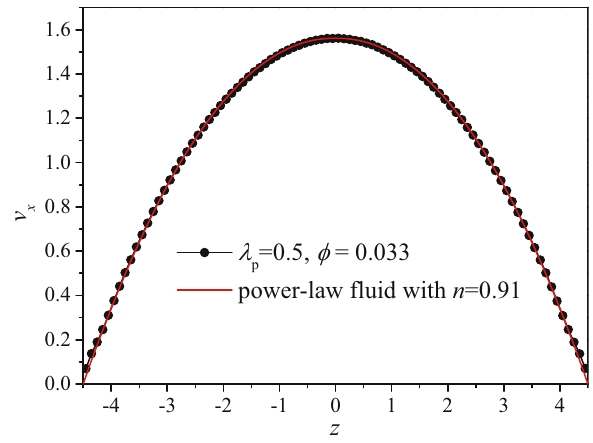
Figure 16: The velocity pro fi le of the wormlike chain solution with ϕ = 0.033 for = λ 0.5 peff compared to that of the power - law fl uid with n = 0.91.